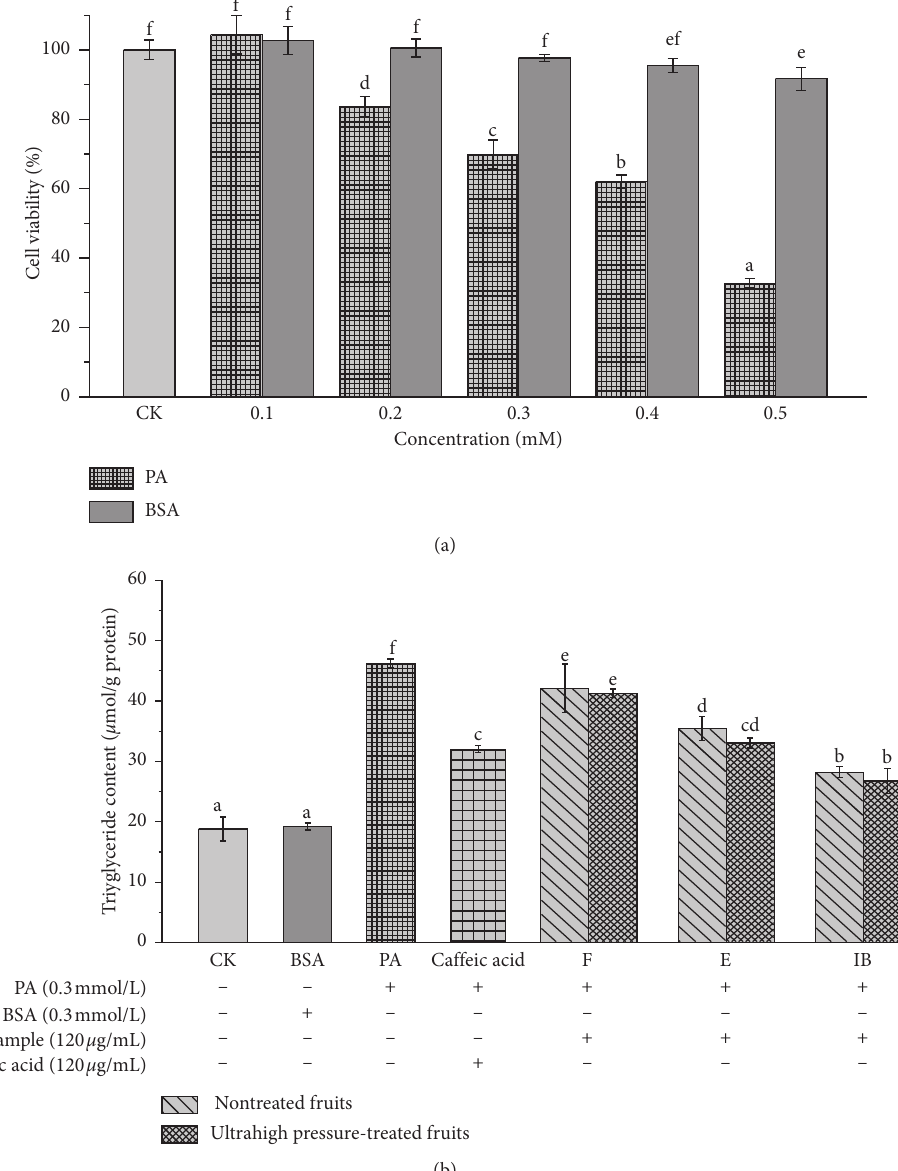
Figure 1: (a) The MMTresult of PA, (b) the effects of phenolic fractions from oil palm fruits with or without ultrahigh pressure treatment and caffeic acid on PA-induced TG accumulation. Data are expressed as mean ± SD ( n � 3). Mean values with different letters are sig- nificantly different ( p < 0 . 05). CK: control group; BSA: BSA/NaOH complex solution; PA: PA/BSA complex solution; “F” free phenolic fraction; “E” esterified phenolic fraction; “IB” insoluble-bound phenolic